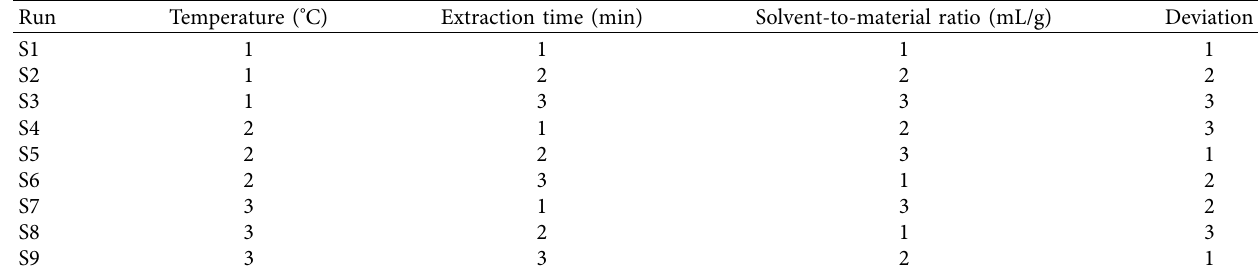
Table 3: The orthogonal table of sample solutions.